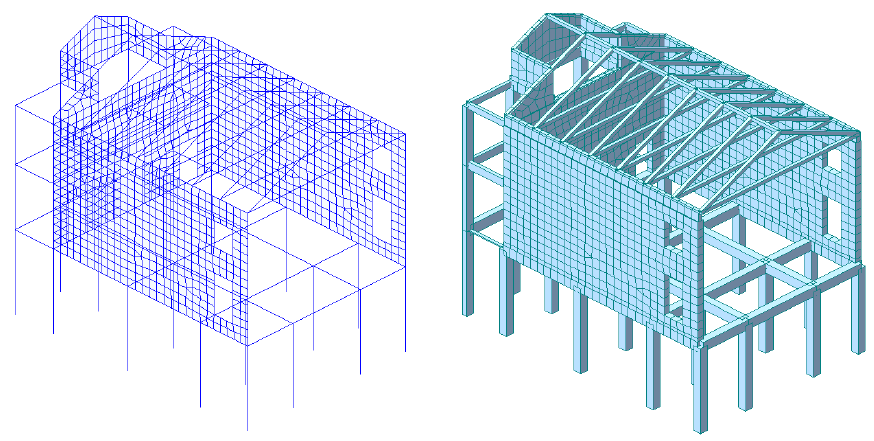
Figure 13. Wireframe ( left ) and solid ( right ) representation of the finite element model used for the non-linear analysis of the central